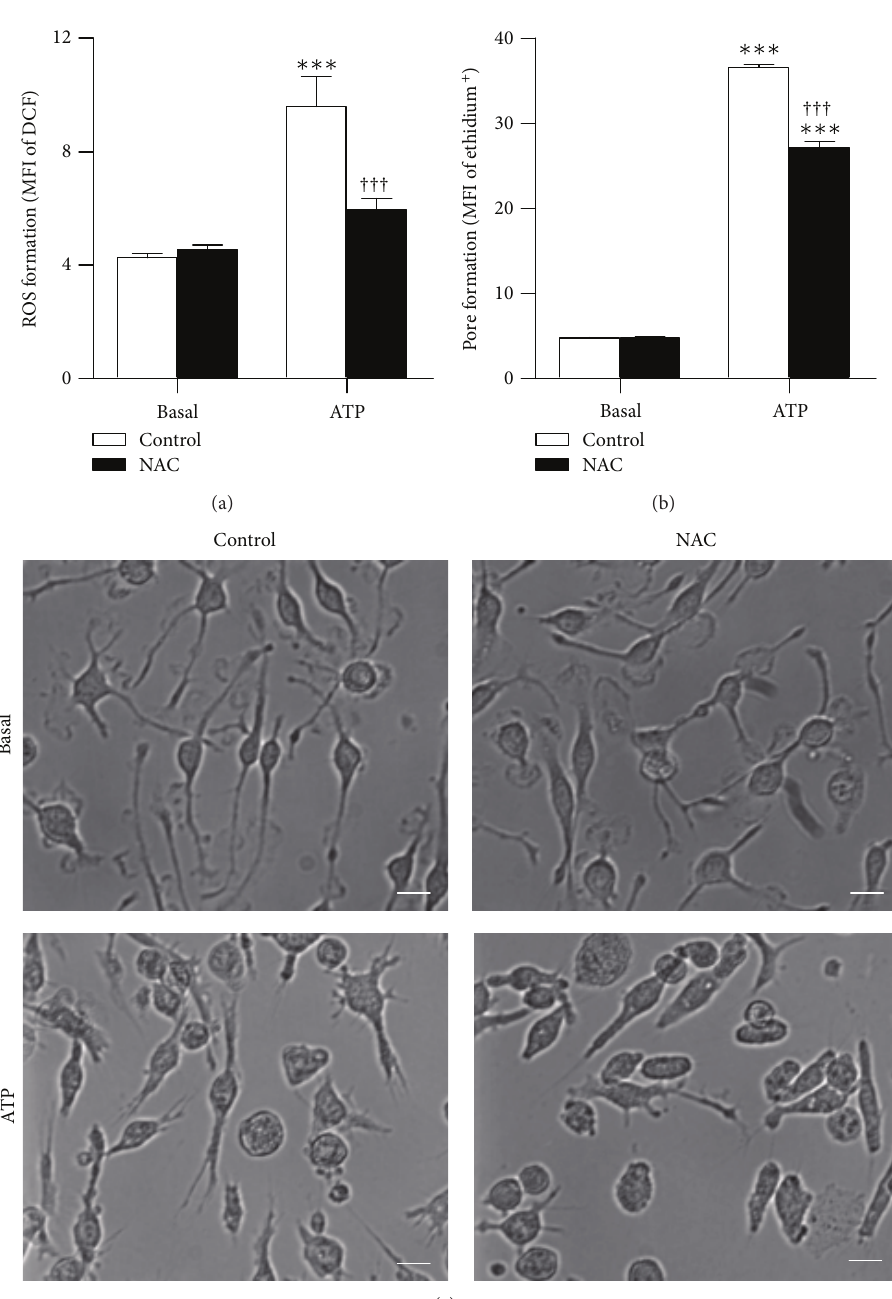
F 5: e ROS scavenger NAC inhibits P2X7-induced ROS and pore formation in EOC13 microglial cells. (a and c) Adherent DCF- loaded EOC13 cells or (b) suspended EOC13 cells in NaCl medium were preincubated in the absence (control) or presence of 40mM